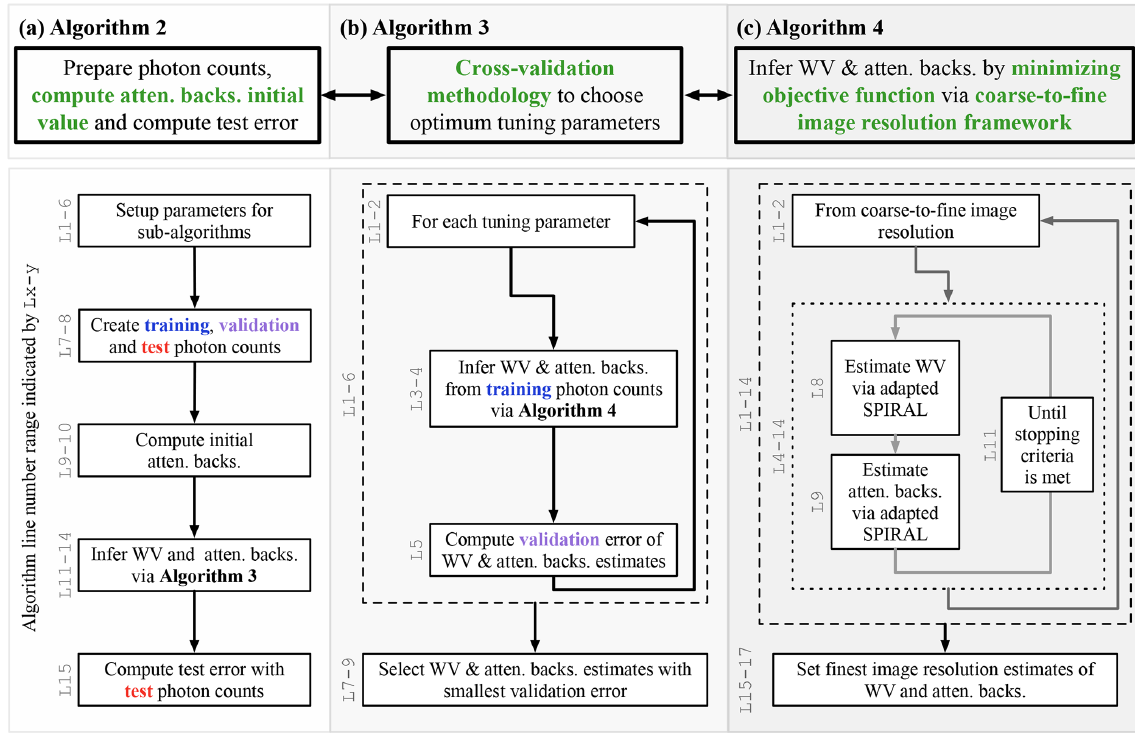
Figure 2. Pictorial overview of Alg. 2 and its sub-algorithms (Algs. 3 and 4) for inferring the water vapor (WV) and uncalibrated attenuated- backscatter cross section (atten. backs.). The corresponding algorithm line numbers for each block in the flow diagrams are indicated by the vertical text Lx-y . The blue, violet, and red text is meant to highlight statistically independent datasets generated using Poisson